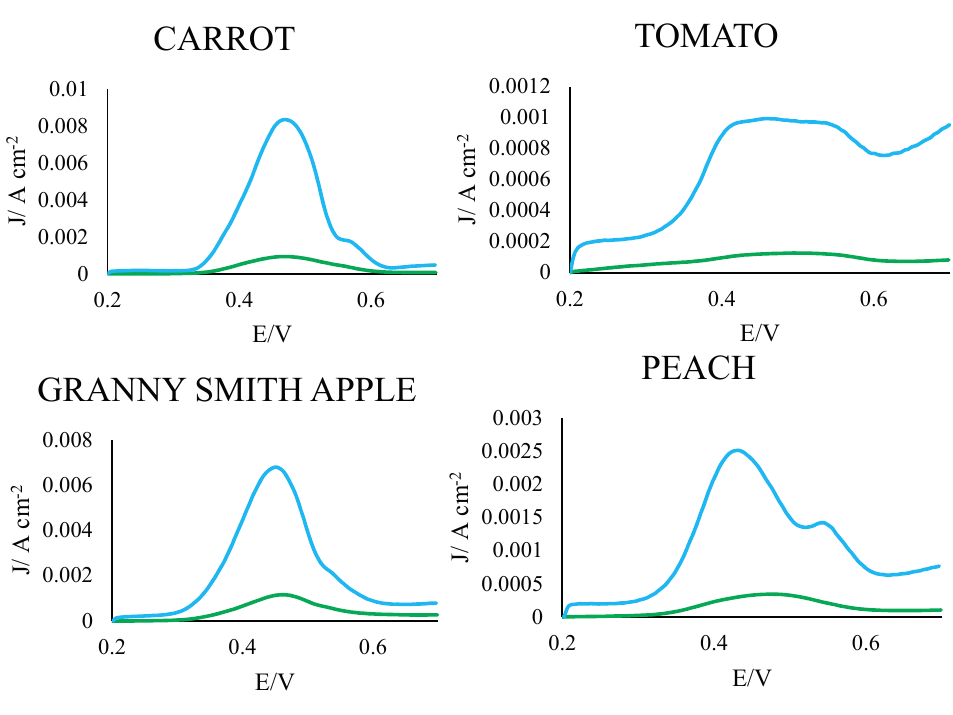
Figure 3. Representative voltammograms of the PGEs (blue) and GCEs (green) tested in